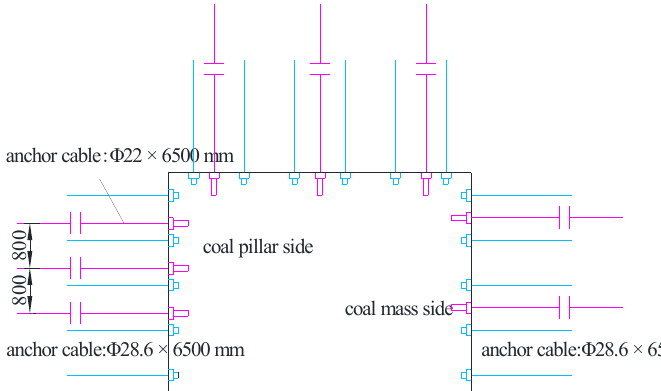
Figure 13. Cross-sectional view of the reinforcement support of the two ribs of the roadway.